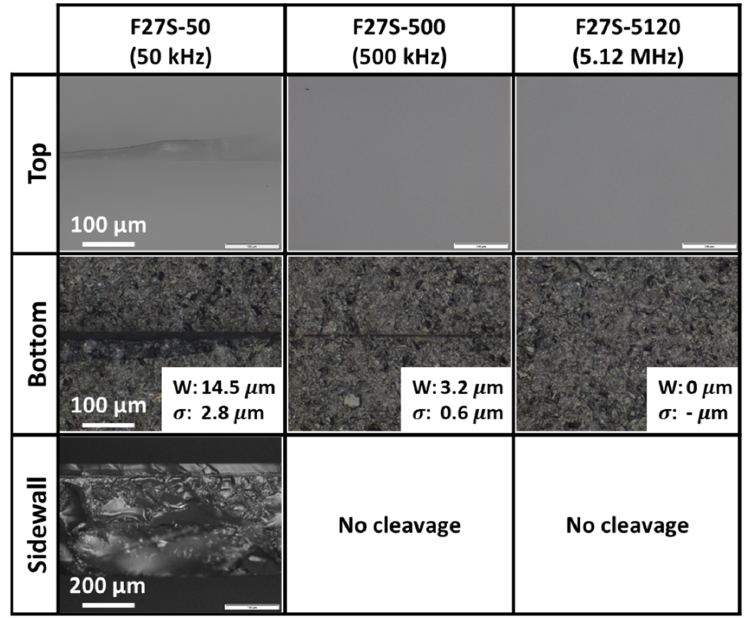
Figure 5. Optical images of samples’ surfaces and sidewall profiles at 0.1 mm/s scanning speed for Experiment F27S (i.e., after full-section irradiation with 27 foci and a 7.5 mm EFL at 1.13 W) at various pulse repetition rates (i.e., 50, 500 and 5120 kHz), with the respective widths (W) and standard deviations ( 𝜎 ).